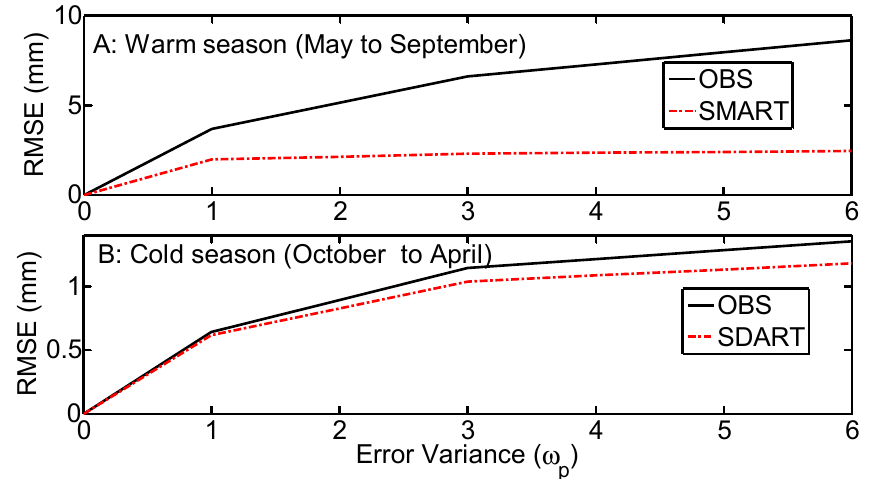
Figure 4. The RMSE of corrected ( A ) SMART- and ( B ) SDART-corrected precipitation for various levels of (synthetically-introduced) precipitation error.